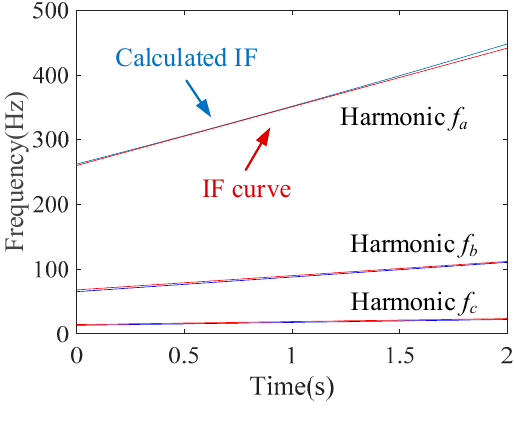
Figure 11. Calculated IF curves.